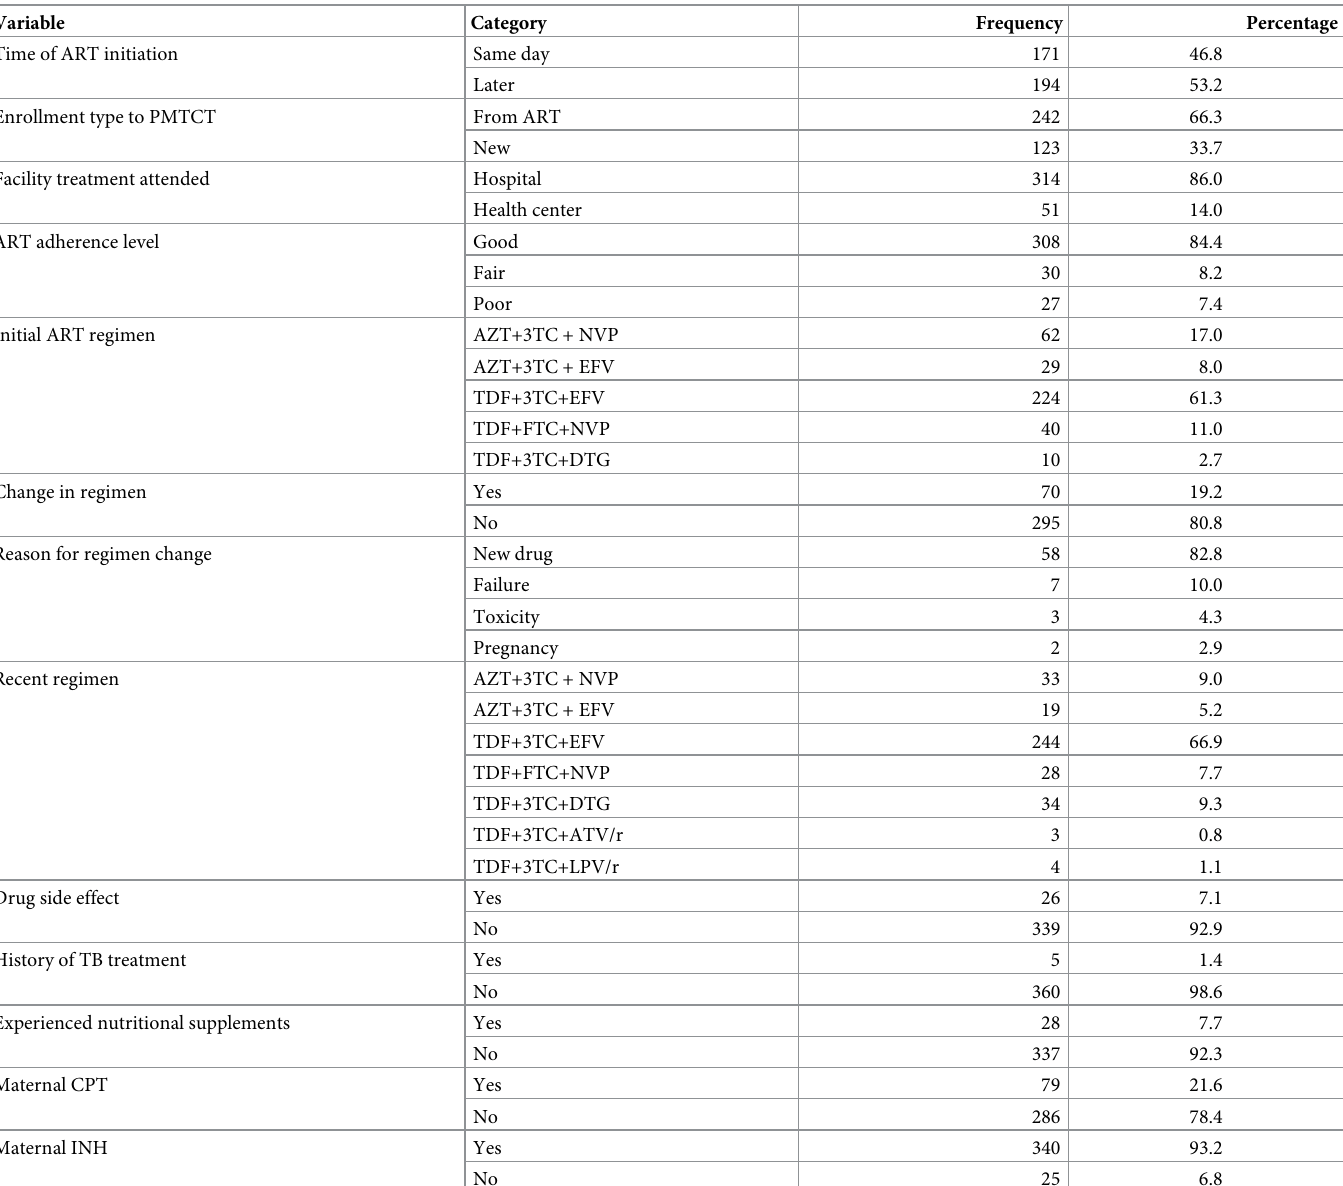
Table 3. Treatment-related characteristics of women on option B+ PMTCT program in Pawi district health facilities, northwest Ethiopia, June 2013- March